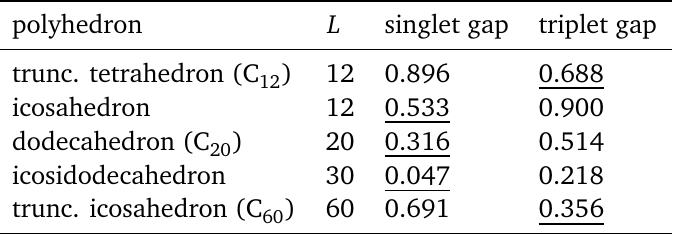
Table 2: Comparison of the singlet and triplet gaps for various polyhedra with L vertices. The smaller value is